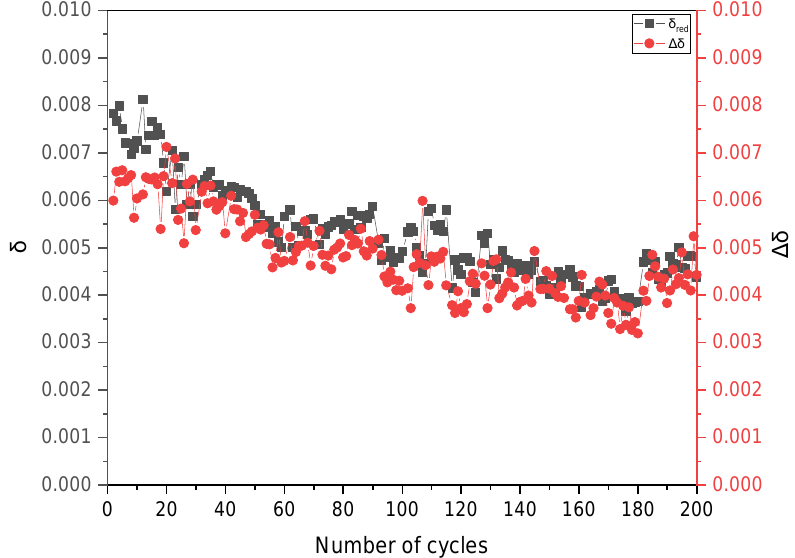
Figure 8. Change in non-stoichiometry and reduction extent during the course of 200 temperature-swing cycles.